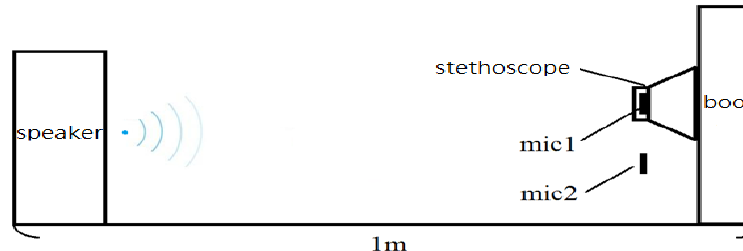
Figure 7. Schematic diagram of the experimental site I.